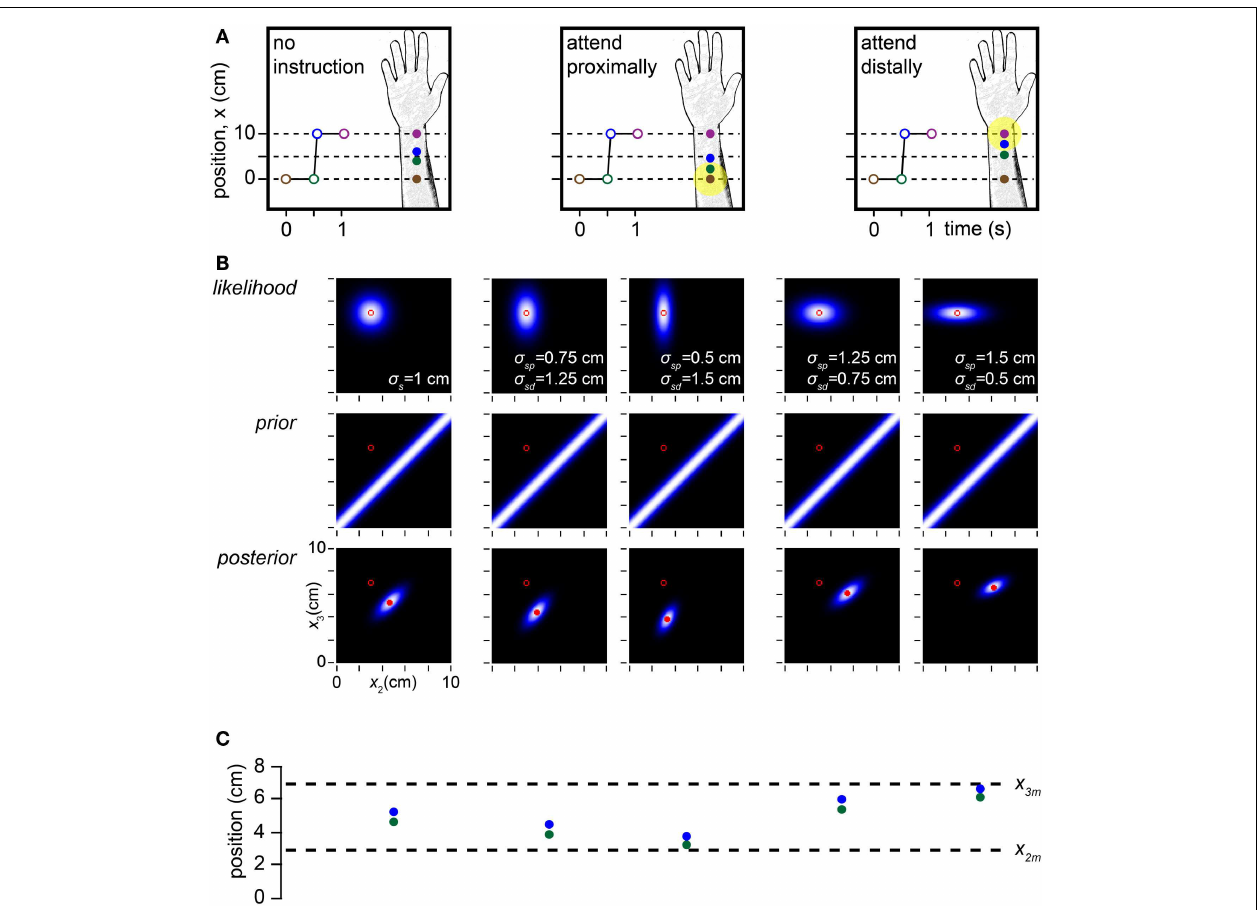
this case, the perceived and measured trajectory midpoints coincide. Center two panels : effect of σ sp < σ sd , where the subscripts p and d refer to the proximal and distal arm areas.The greater the reduction of σ sp relative to σ sd , the more the perceived trajectory migrates proximally toward the tap 2 measurement. Right two panels : effect of σ sd < σ sp .The greater the reduction of σ sd relative to σ sp , the more the perceived trajectory migrates distally toward the tap 3 measurement. For all plots in (B) , the measurements ( x 2 m , x 3 m ) were (3, 7cm), the time between taps 2 and 3 was 0.06s, and σ v was 10cm/s. (C) The perceived (mode of posterior) tap 2 and 3 positions (green and blue circles) for each of the five conditions in (B) directly above, compared to the measured tap positions (dashed